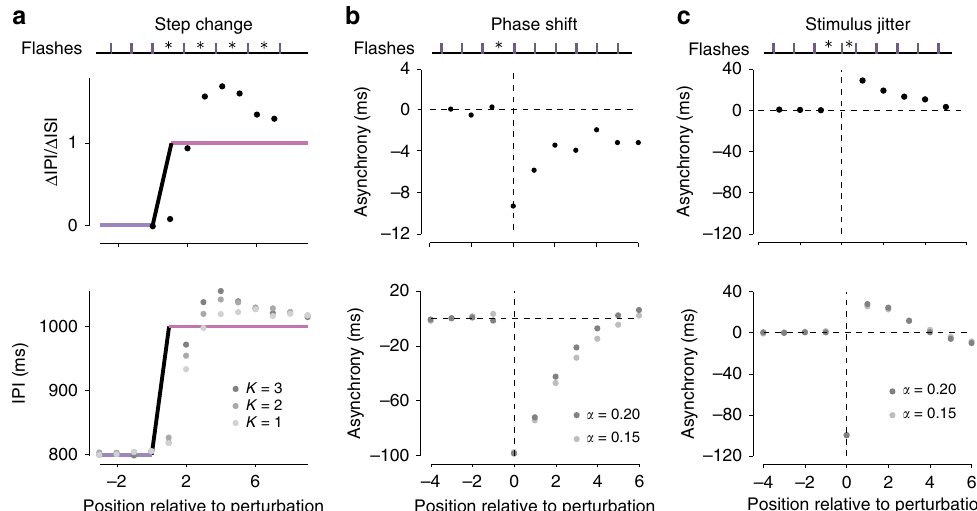
Fig. 6 Circuit response to ISI perturbations. a Model and human responses to a step change in the inter-stimulus-interval (ISI). Top: schematic of the task design. Vertical bars indicate the timing of a fl ash sequence with the distance between bars corresponding to the ISI. Asterisks denote ISIs that are perturbed relative to the initial ISI. Middle: average human step change response. Data reproduced from Bavassi et al. 37 . Circles plot the change in inter- production-interval ( Δ IPI) relative to the change in ISI ( Δ ISI). Blue and purple lines plot ideal performance before and after the step change, respectively. Δ IPI/ Δ ISI is de fi ned as 0 for Δ ISI = 0. Bottom: average IPI of the circuit model (circles) to a step change from 800 ms (blue line) to 1000 ms (pink line). The level of gray indicates model behavior for different values of the parameter, K . b Model and human responses to a phase shift in the stimulus timing. Top: task schematic, as in panel a . A phase shift was induced by increasing the duration of one interval (asterisk). Middle: average human asynchrony following a 10 ms phase shift from a 500 ms ISI. Data reproduced from Repp 38 . Bottom: average model asynchrony (circles) following a 100 ms phase shift from an ISI of 500 ms. Following the analysis of human behavior, we removed the mean asynchrony adopted by the model before the perturbation. The horizontal dashed line indicates no asynchrony and the vertical dashed line indicates the time of the fi rst fl ash following the perturbation. The level of gray indicates circuit model behavior for different levels of the parameter, α . c Model and human responses to temporal jitter of a single stimulus. Top: task schematic, as in panel a. The timing of a single stimulus was jittered by increasing one interval by 100 ms, followed by decreasing the subsequent interval by 100 ms (asterisks) from an ISI of 500 ms. Middle: average human asynchrony following stimulus jitter. Data reproduced from Repp 67 (asynchrony to the perturbed stimulus not shown). Bottom: average model asynchrony. Conventions as in panel ( b